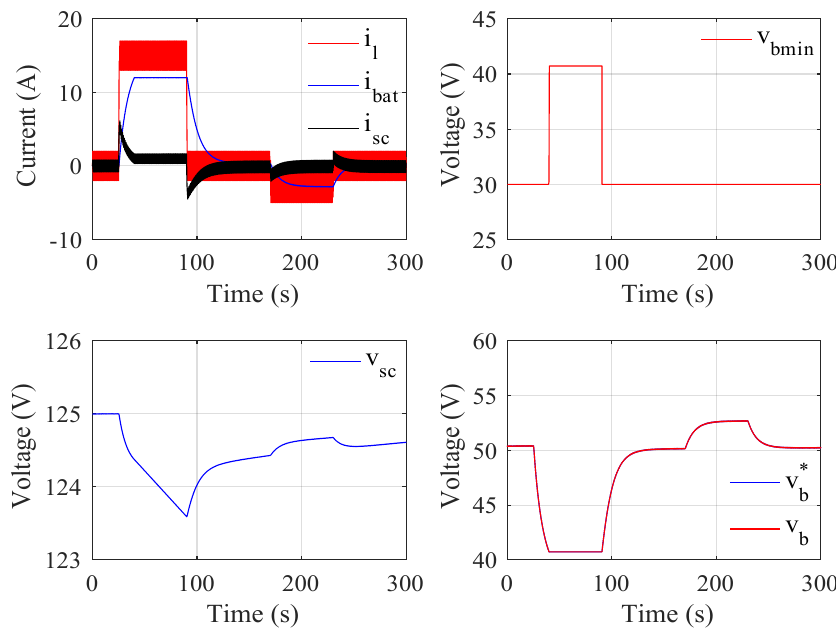
Figure 7. Simulation results, in discharge mode.